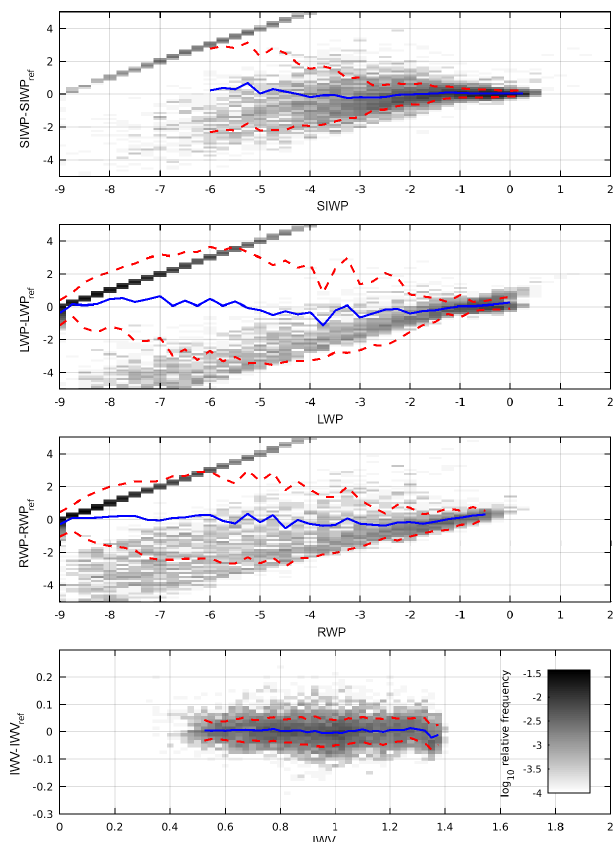
Figure 4. Two-dimensional histograms of the difference between components of the retrieved state vector and the corresponding ICON model state vector, as a function of the retrieved state vec- tor. The components of the state vectors are defined as the decadal logarithm of the ratio of the specific quantity and the specific unit path; therefore they are unitless. The offsets O of the components of the retrieved state vector are shown as blue lines and the corre- sponding standard deviations σ O are shown as red lines. For the hydrometeor paths, an x value of − 3 corresponds to a value of 10 − 3 kgm − 2 = 1gm − 2 . For IWV, an x value of 1 corresponds to a value of 10 1 kgm − 2 = 10kgm − 2